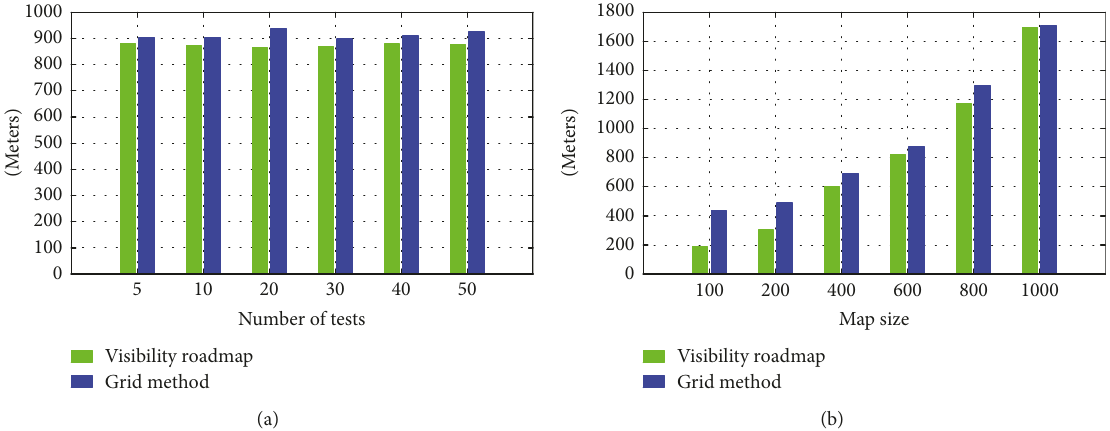
Figure 12: Comparison of two algorithms regarding traveled distance: (a) based on number of tests in Table 5; (b) based on map size in Table